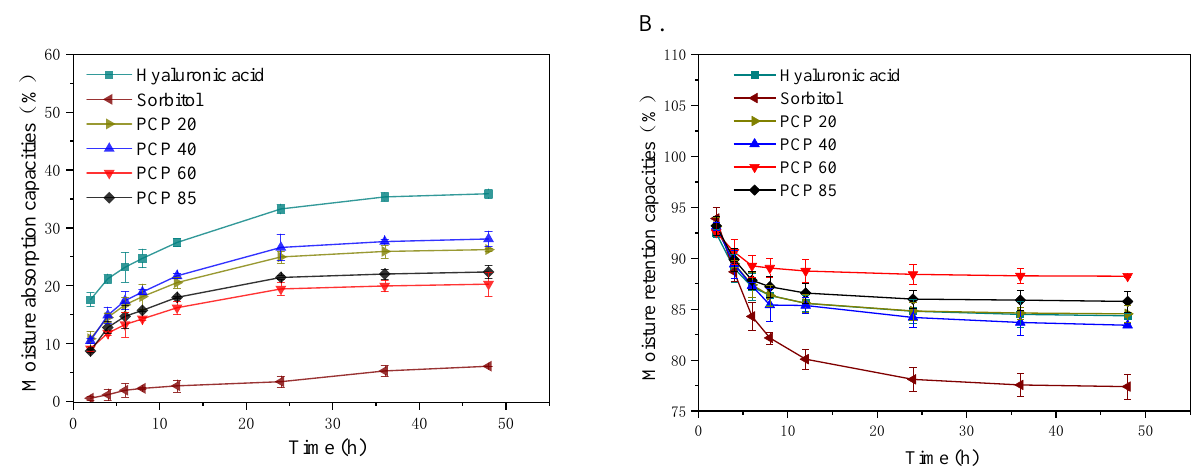
Figure 1. ( A ) The moisture absorption of samples at RH = 81%. ( B )The moisture retention of samples at RH = 43%.